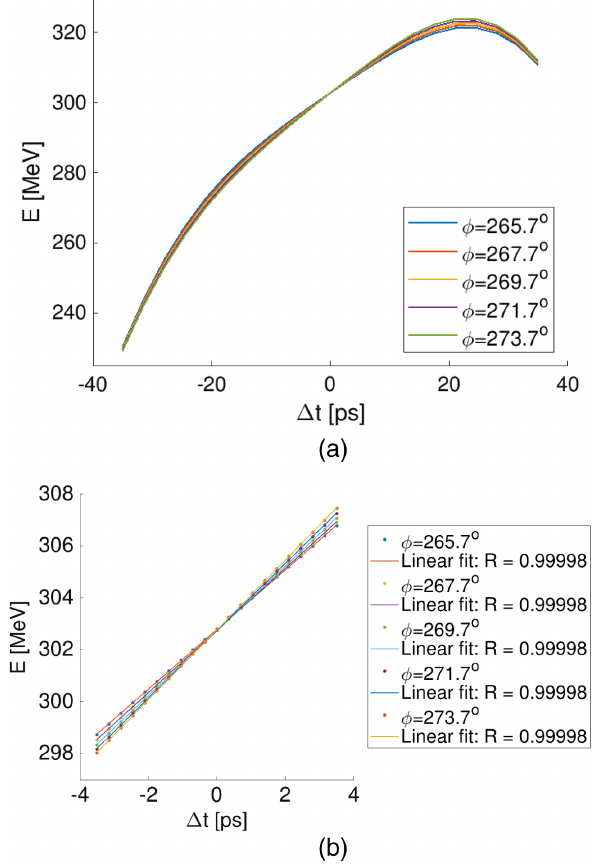
FIG. 1. Numerical simulation of the beam energy at the SwissFEL injector as a function of arrival time jitter by varying the phase of the X-band in an extended (a) and a restricted (b) time